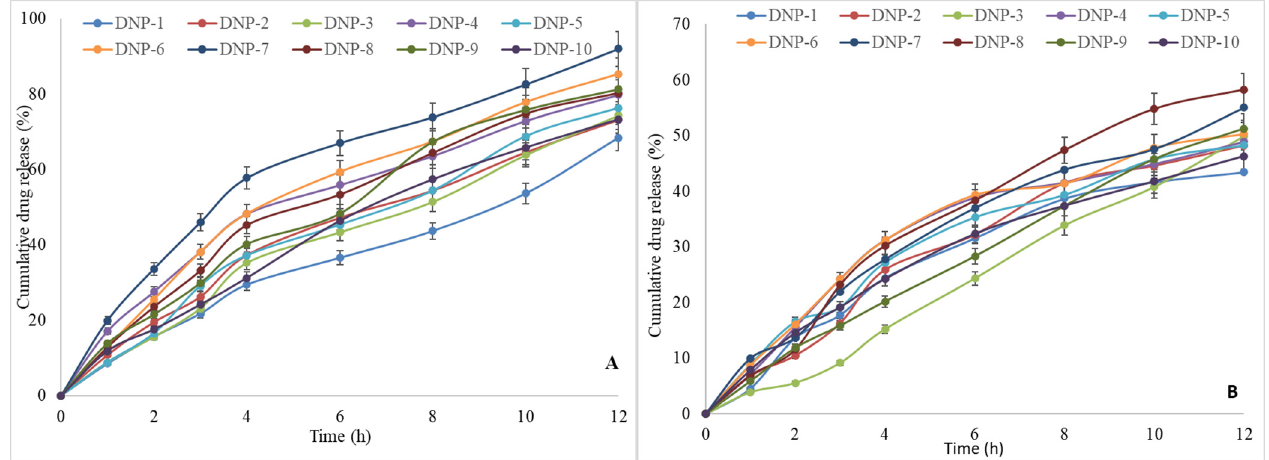
Figure 4. In vitro drug release profile of Kaempferol nanoparticles (DNP-1 to DNP-10) in pH 1.2 ( A ) and pH 6.8 ( B ). Study performed in triplicate and data shown as mean ± SD.